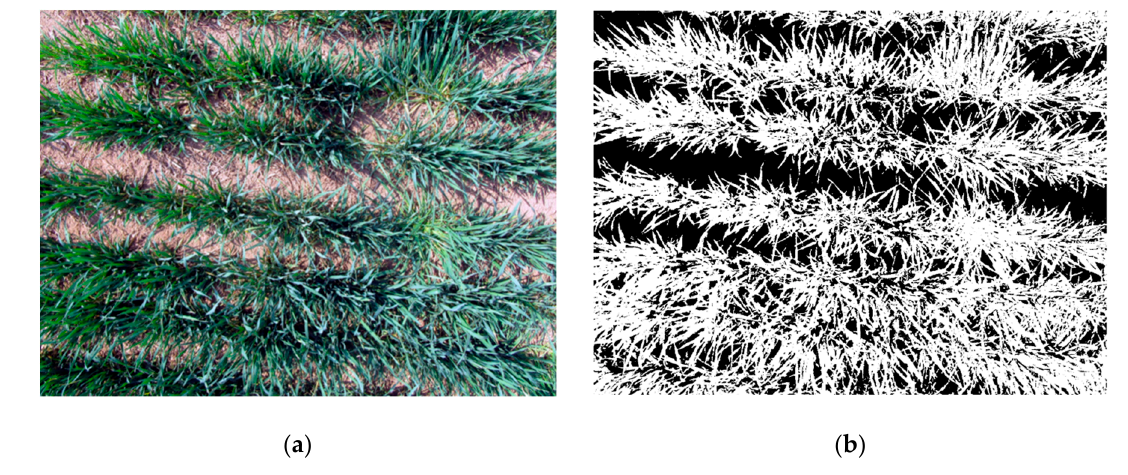
Figure 2. An example of FVC extraction from a digital image for winter wheat. The left picture is the original camera image ( a ), and the right picture is the corresponding extraction result ( b ).